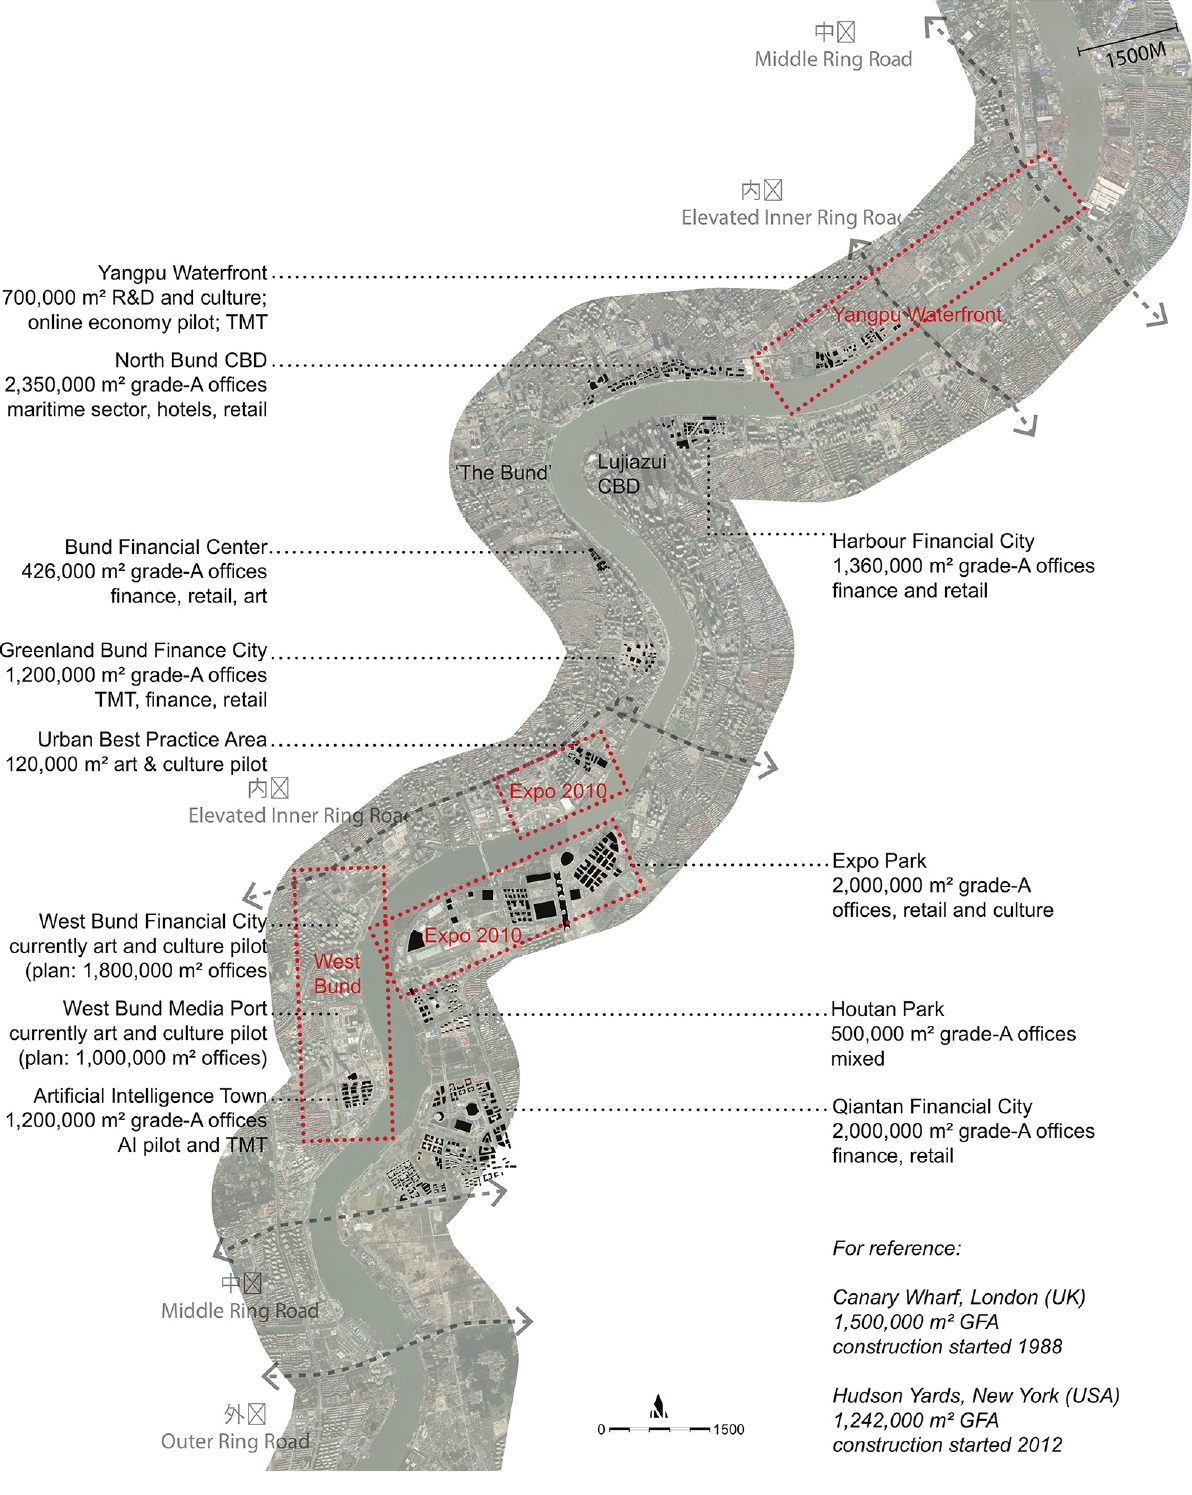
Figure 1. Map with urban megaprojects since 2012 along the central section of the Huangpu River. Source: Image by Harry den Hartog and Jiawei Hu; Satellite photo as underlay by Shanghai‐tianditu